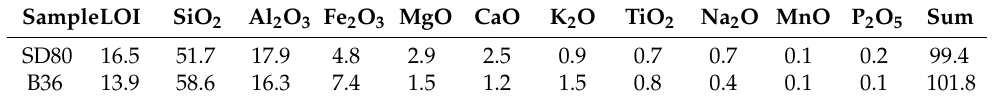
Table 2. XRD quantification results based on Rietveld-Refinement. Ant: anatase, Brt: baryte, Cal: calcite, Crs: cristobalite, Fsp: feldspar, Kln: kaolinite, Sme: smectite, Py: pyrite, Qz: quartz, n.d.: not